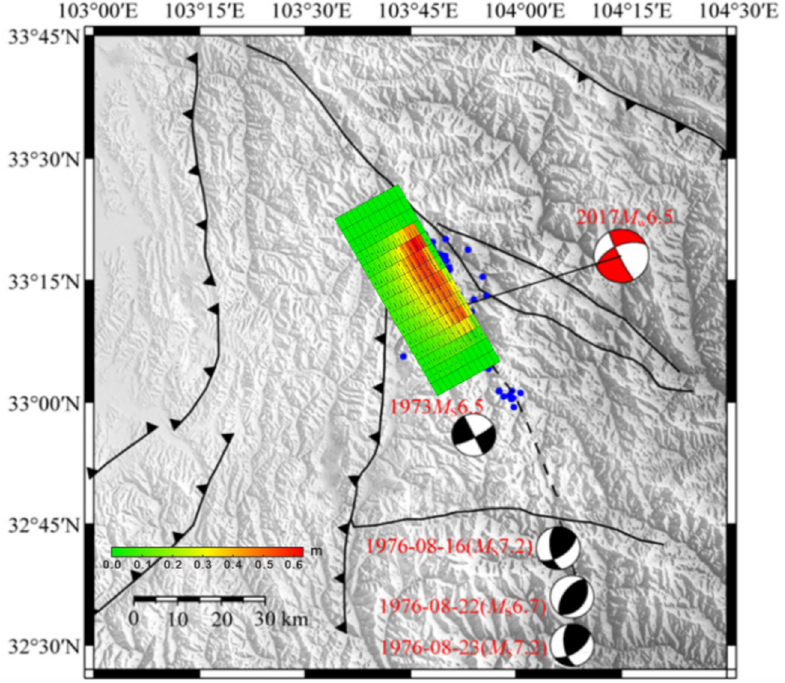
Figure 12. Fault slip distribution from inversions constrained by InSAR. It shows that the fault rupture movement is dominated by left-lateral strike-slip, the focal depth is about 9 km, the strike is 266.49 ◦ , the dip angle is 41 ◦ , and the slip angle is –160.74 ◦ . The comparison between the inversion results of Harvard University,